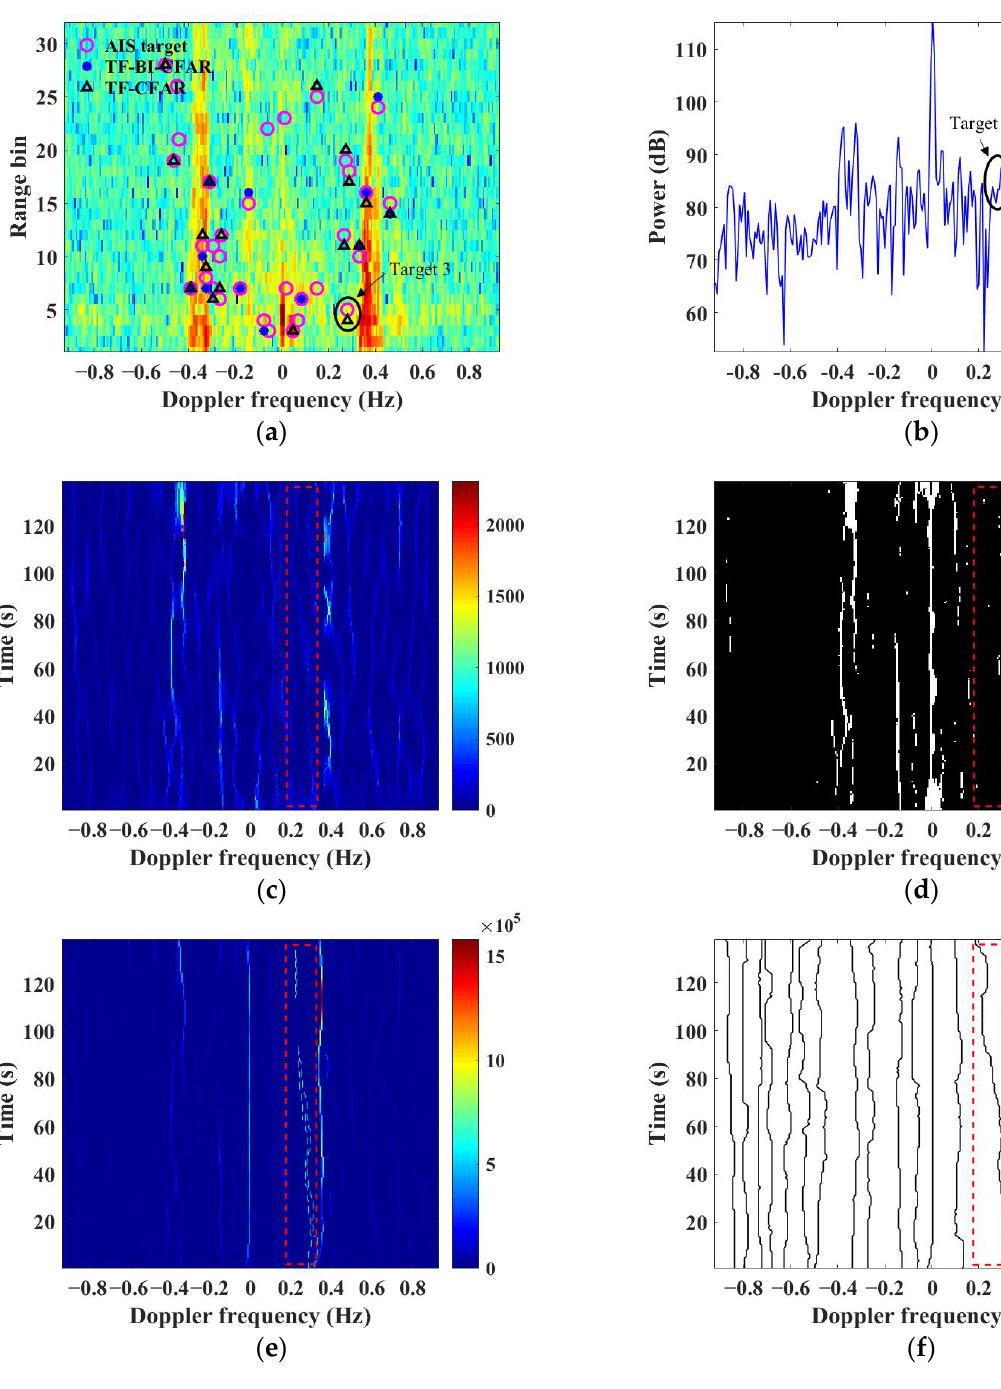
Figure 8. Comparison of clutter edge by TF-BI-CFAR and TF-CFAR at 16:15 on 5 October 2015 and ( c – f ) are from TF-BI-CFAR and TF-CFAR, respectively. ( a ) target matching map on RD; ( b ) power spectrum at the 5th range bin; ( c ) SST image at the 5th range bin; ( d ) binary grayscale image of ( c ); ( e ) TF ridges marked by Hessian matrix; ( f ) TF ridges extracted from ( e ).